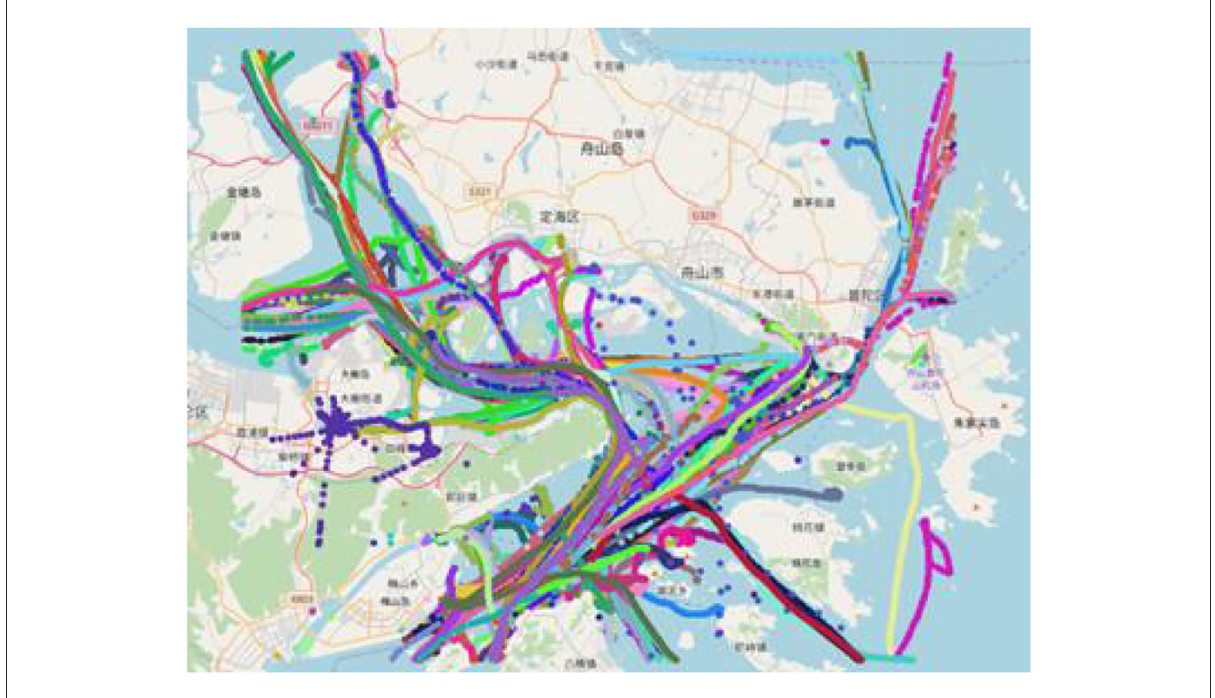
FIGURE4 Trajectory chart of a certain day in Dinghai